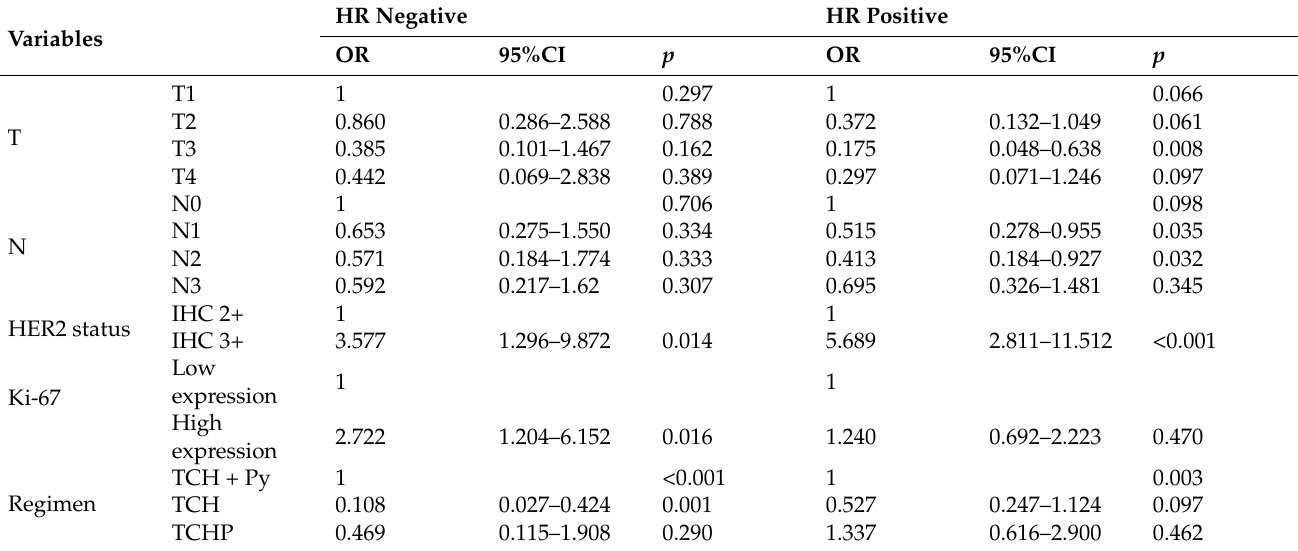
Table 4. Multivariate analyses of factors associated with pCR in subgroup by HR